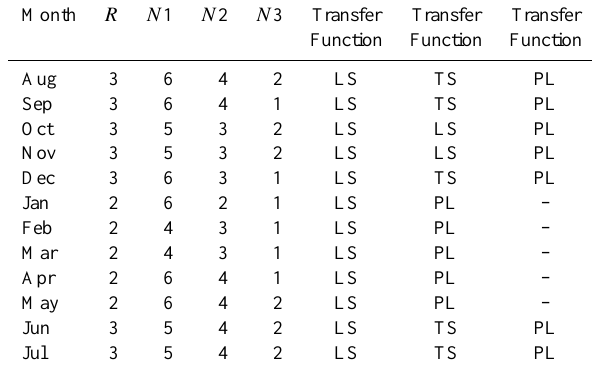
Table 1. The transfer functions used in each layer of the net- works are also listed in Table 1. All twelve networks utilize the backpropagation algorithm during the training